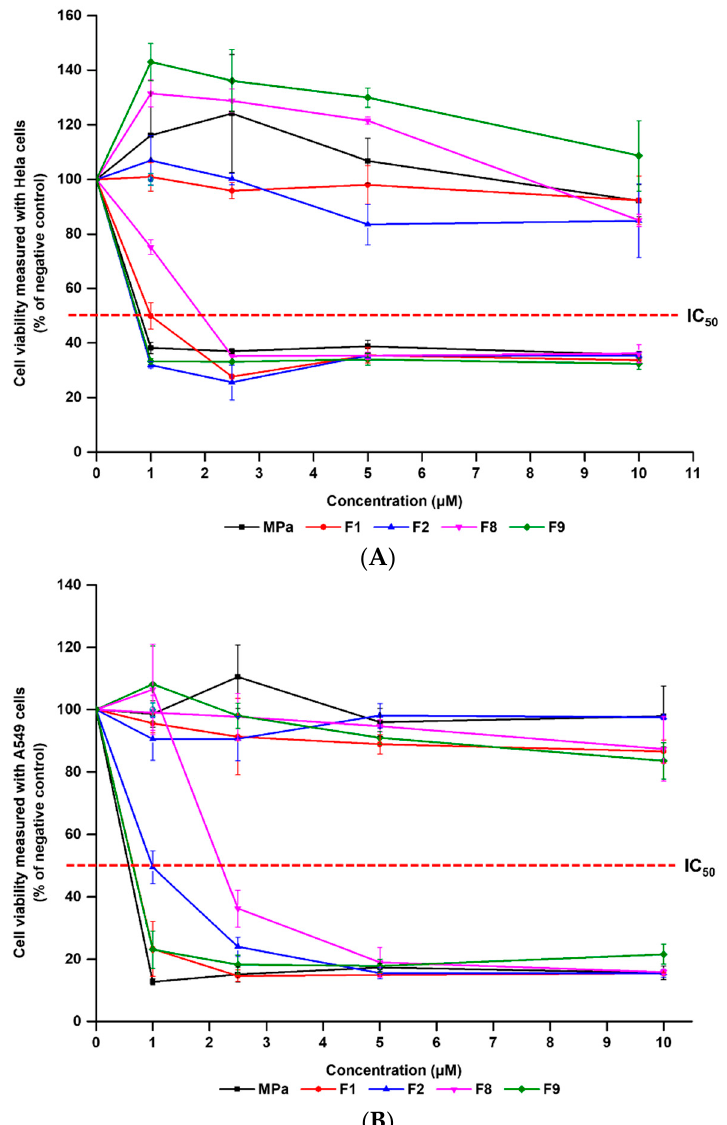
Figure 9. Viability of two cancer cell lines (HeLa and A549) treated with free MPa solution, F1, F2, F8, and F9. The cell viability was measured using WST assay. ( A ) Dark and light cytotoxicity of HeLa cells, ( B ) dark and light cytotoxicity of A549 cells. Results are expressed as means ± standard deviations of three independent experiments ( n = 3).